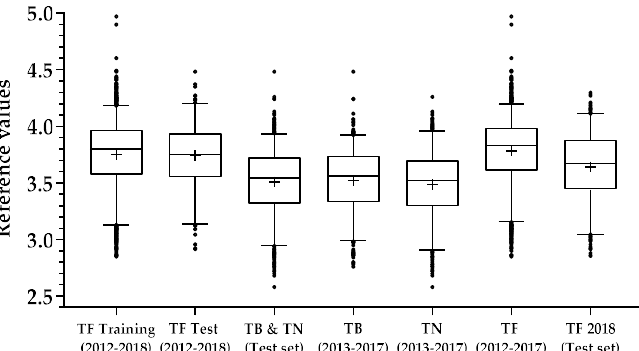
Figure A1. Boxplot of the descriptive statistics for sugar content reference values used for the training process and independent test phases. The boxes represent the 25th, 50th and 75th percentiles, the whiskers represent the fifth and 95th percentiles, the lower and upper open circles represent the mini- mum and maximum values, and the plus symbol denotes the mean values.